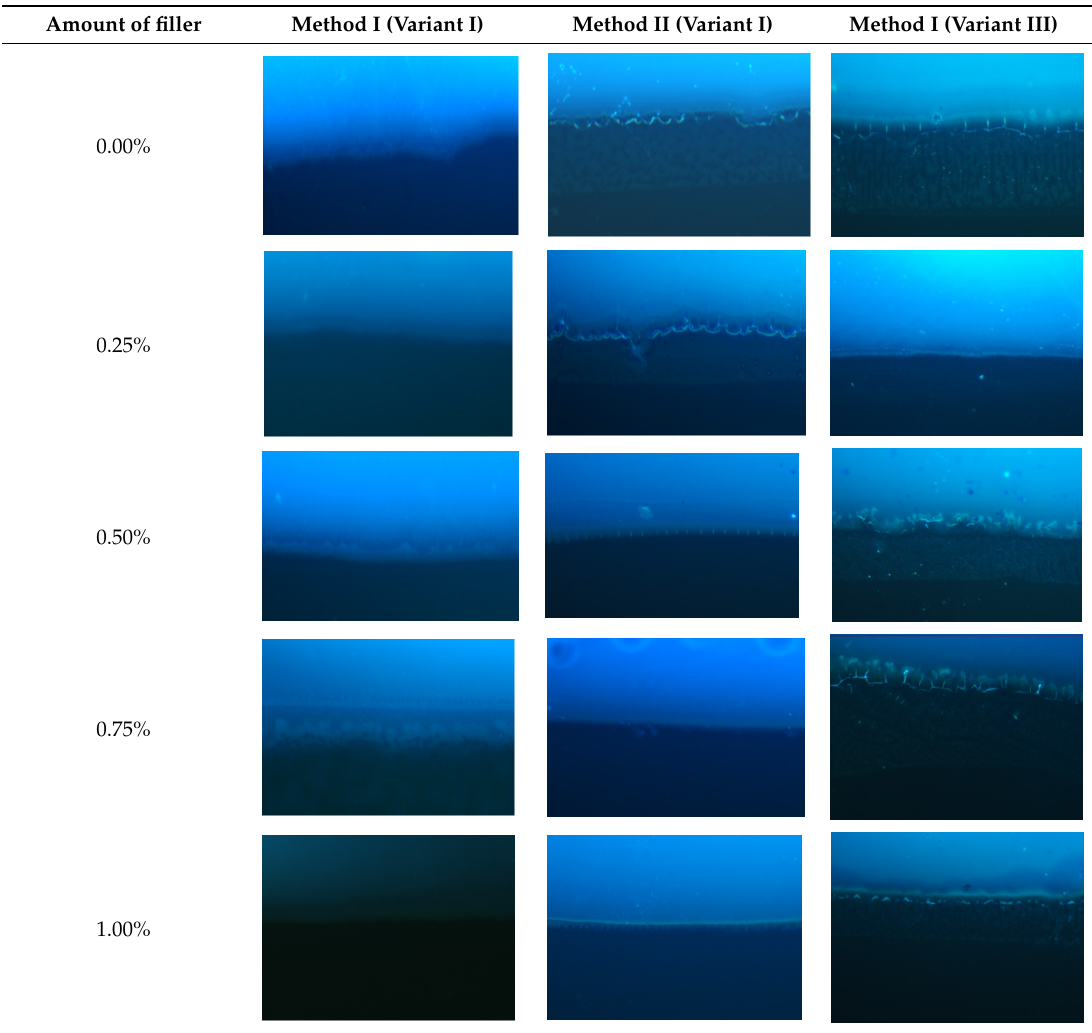
Table 6. Microscopic images of specimens prepared according to Methods I and II and subjected to seasoning (Variants I–III).